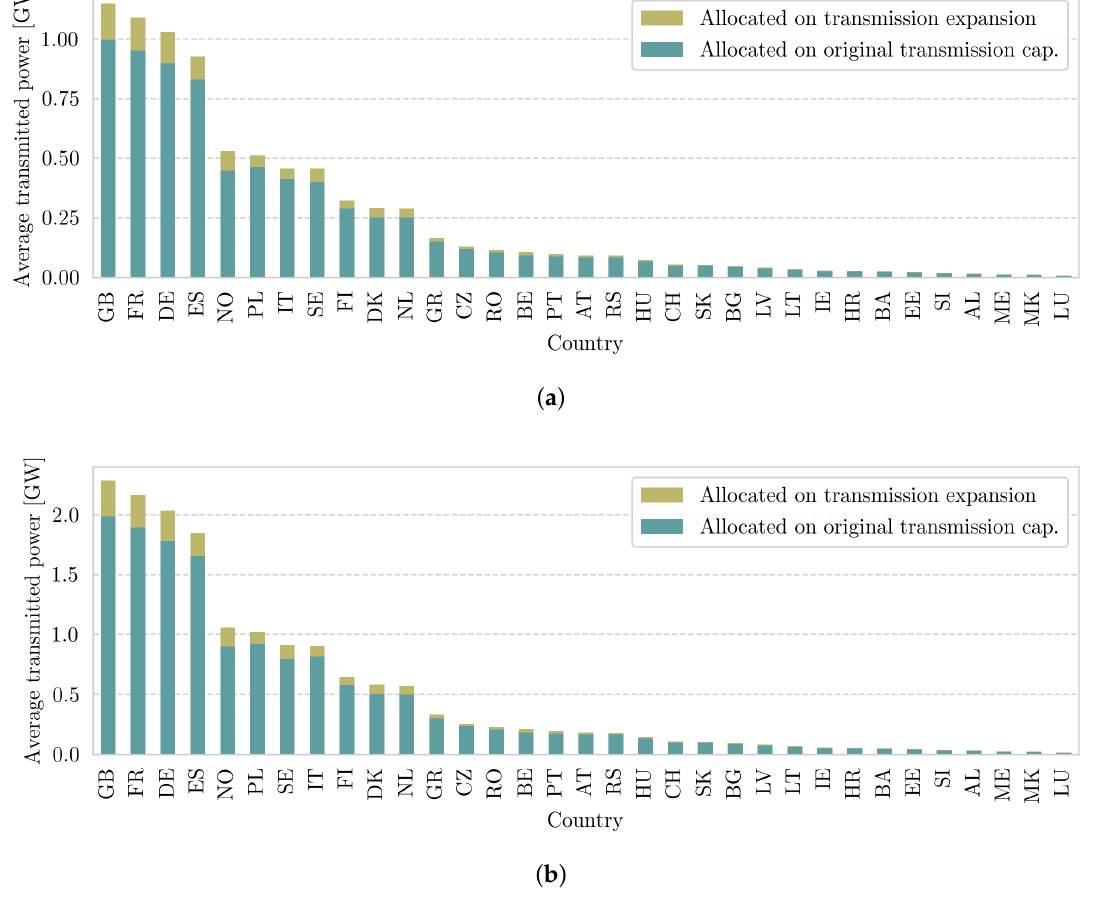
Figure 6. Country-wise flow allocation using EBEs ( a ) and MP ( b ). The flow allocation per country is split into two parts, one for flows that make use of transmission expansion and one for flows that stay within the original capacity bounds. The lookup table for the full country names is given in Appendix A. Both methods (Figure 6a) state that Great Britain is the strongest user of the transmission grid, despite not being the strongest trader of power in the renewable network simulation, which can be seen in Figure